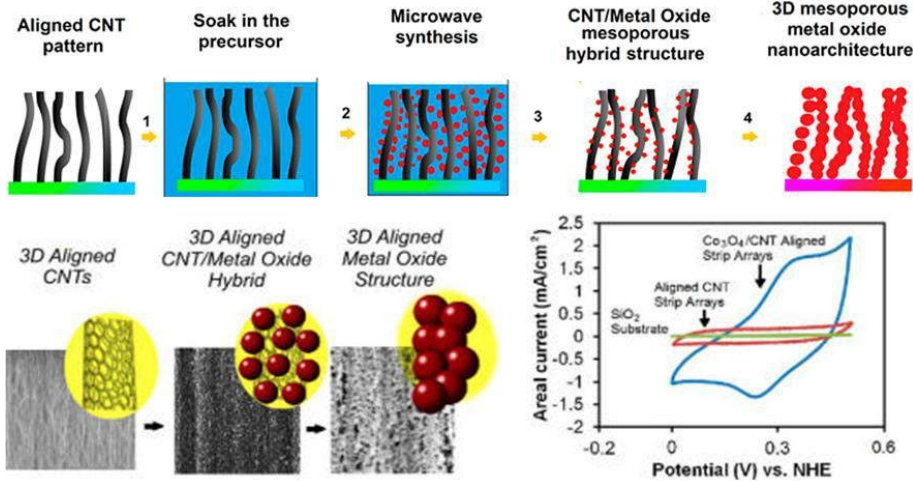
Figure 12. A schematic illustration of the experimental techniques used to create 3D mesoporous hybrid CNT/oxide architectures. Reproduced with permission from [86].